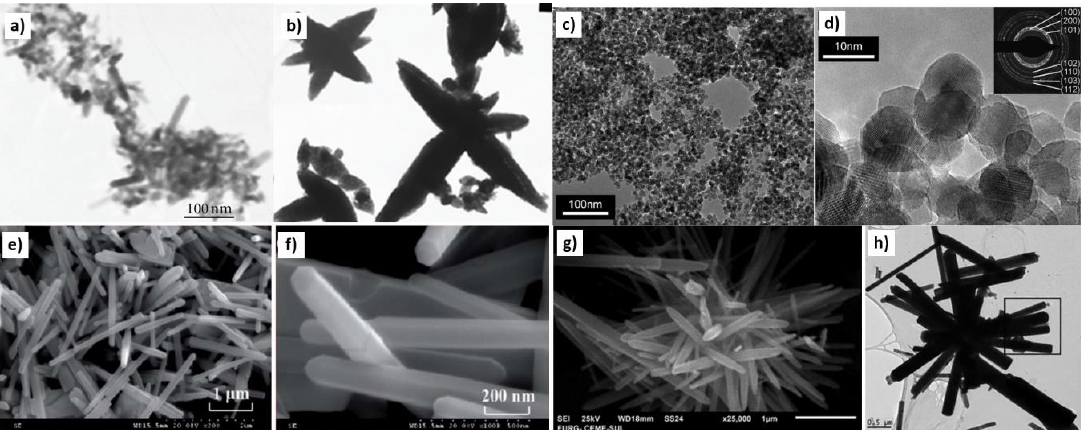
Figure 38. Examples of various ZnO structures obtained by the microwave solvothermal synthesis: ( a ) TEM image of ZnO nanorods (Reprinted from [778], Copyright © 2012 Khoza et al., Article licensed